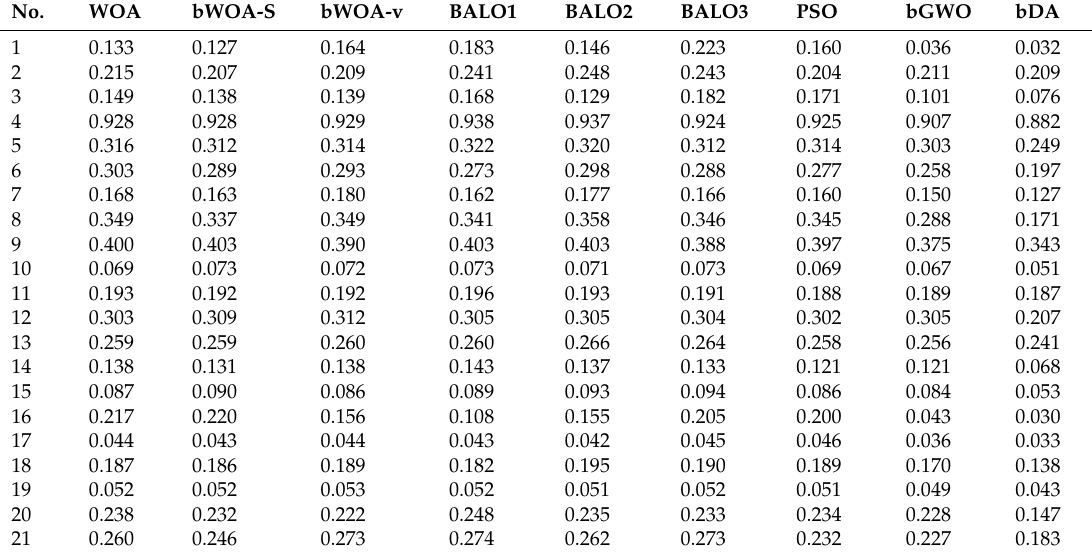
Table 5. Statistical mean fitness measure calculated on the different datasets for the compared algorithms using large initialization.